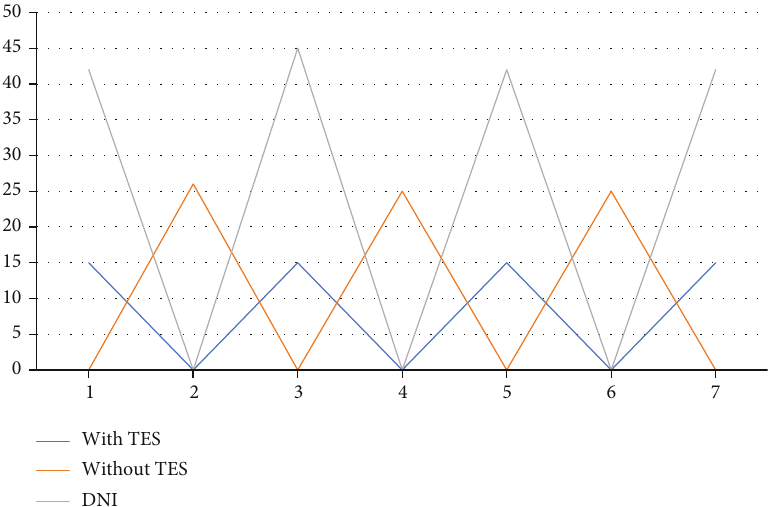
Figure 7: Thermal power exchange between three phases.